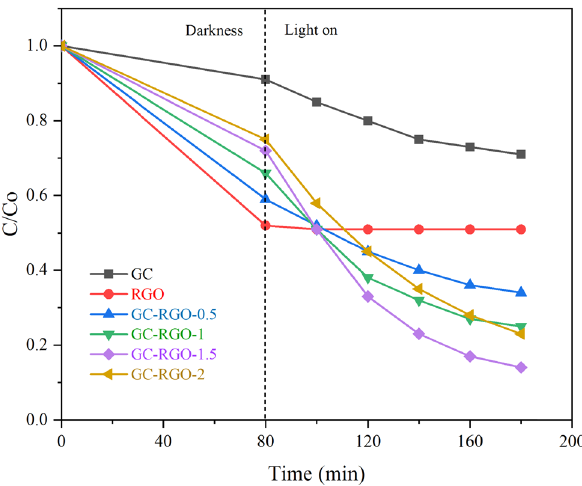
Figure 7: Removal e ffi ciency for gaseous